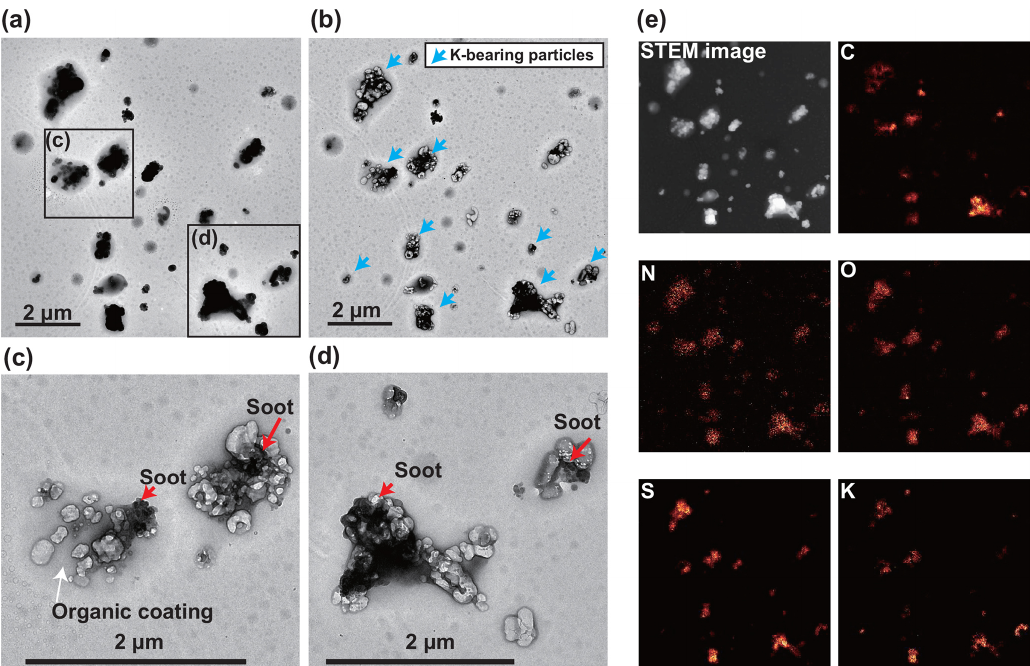
Figure 6. TEM and elemental mapping images of a BB sample (10:40–10:59UTC, 2 April 2018). (a) TEM image of K-bearing particles. (b) The same area of the TEM image (a) but after the STEM-EDS analysis. Beam-sensitive materials are removed, and soot inclusions are more apparent. (c, d) Examples of K-bearing particles containing soot inclusions and organic coatings, which appear in gray in the TEM image. (e) STEM and elemental mapping images for C, N, O, S, and K in the TEM image. The distributions of K, S, and O correspond to the K-bearing particles, and that of C represents the soot and organic